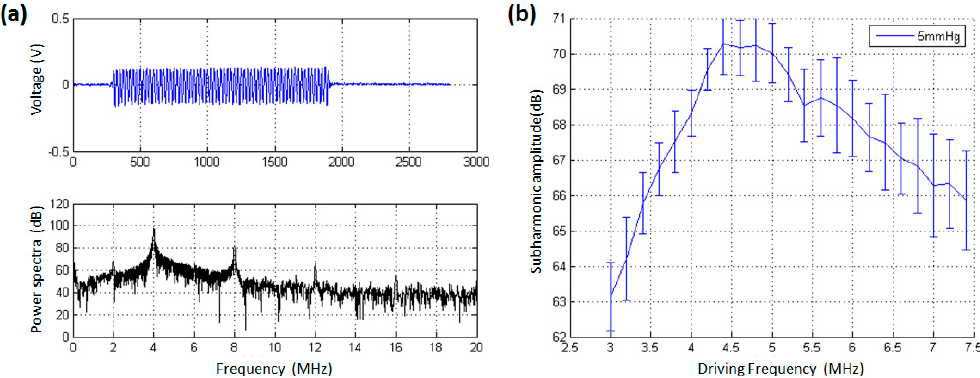
Figure 6. The effect of driving frequency on the subharmonic scattering power from SonoVue microbubbles at 9 min after injecting them. ( a ) An example of the received scattering signals from microbubbles and the corresponding power spectrum. A 64 cycles tone burst was transmitted at the driving frequency of 4 MHz. ( b ) The subharmonic scattering power as a function of driving frequency. The overpressure was 5 mmHg.